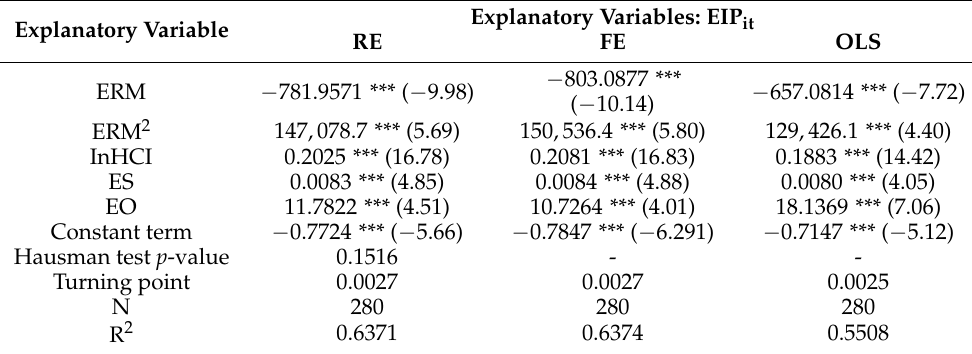
Table 4. Panel model estimation results of the effect of market incentive-based environmental regulation on eco-innovation